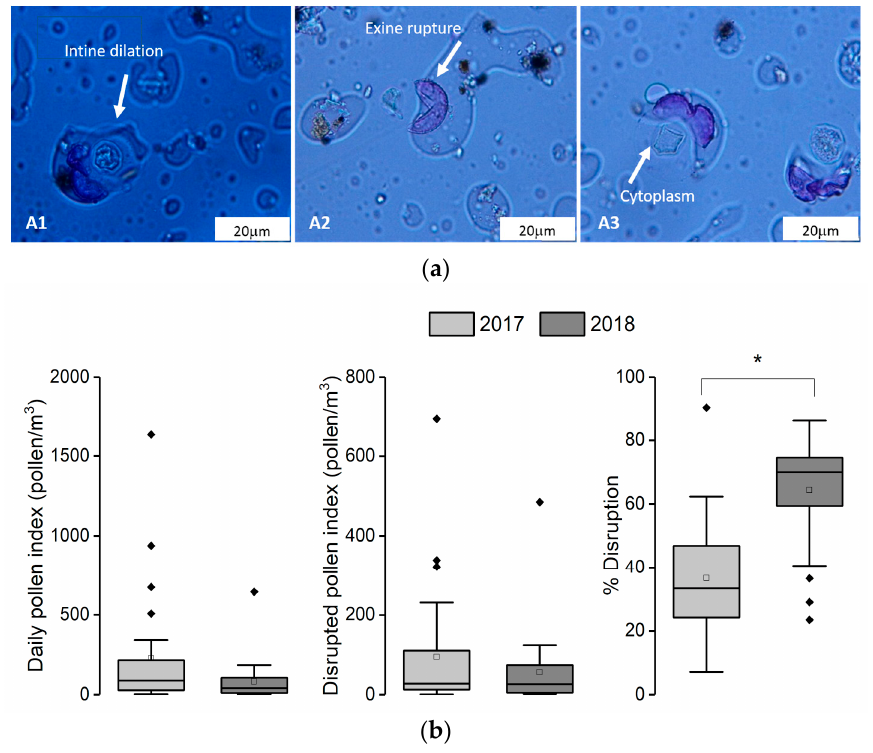
Figure 2. Loss of integrity of Cupressaceae pollen. ( a ) pollen micrographies (with microscopy camera using a 400X amplification). ( b ) daily pollen concentration and pollen disruption (%) in 2017 and 2018 in the studied period. * statistical significance at 5% range ( p < 0.05).